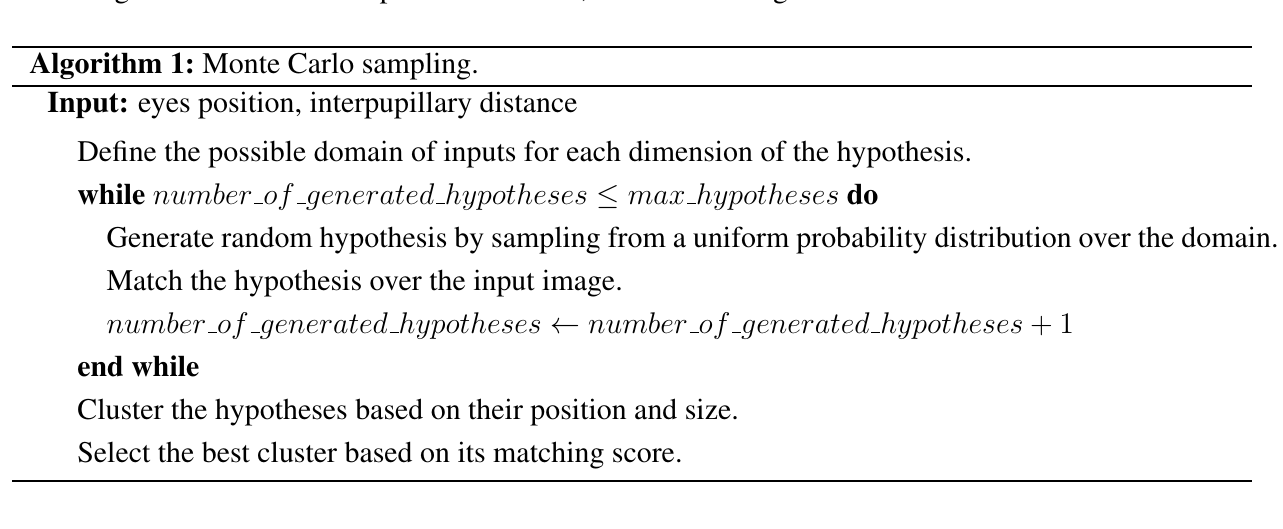
Algorithm 1: Monte Carlo sampling.